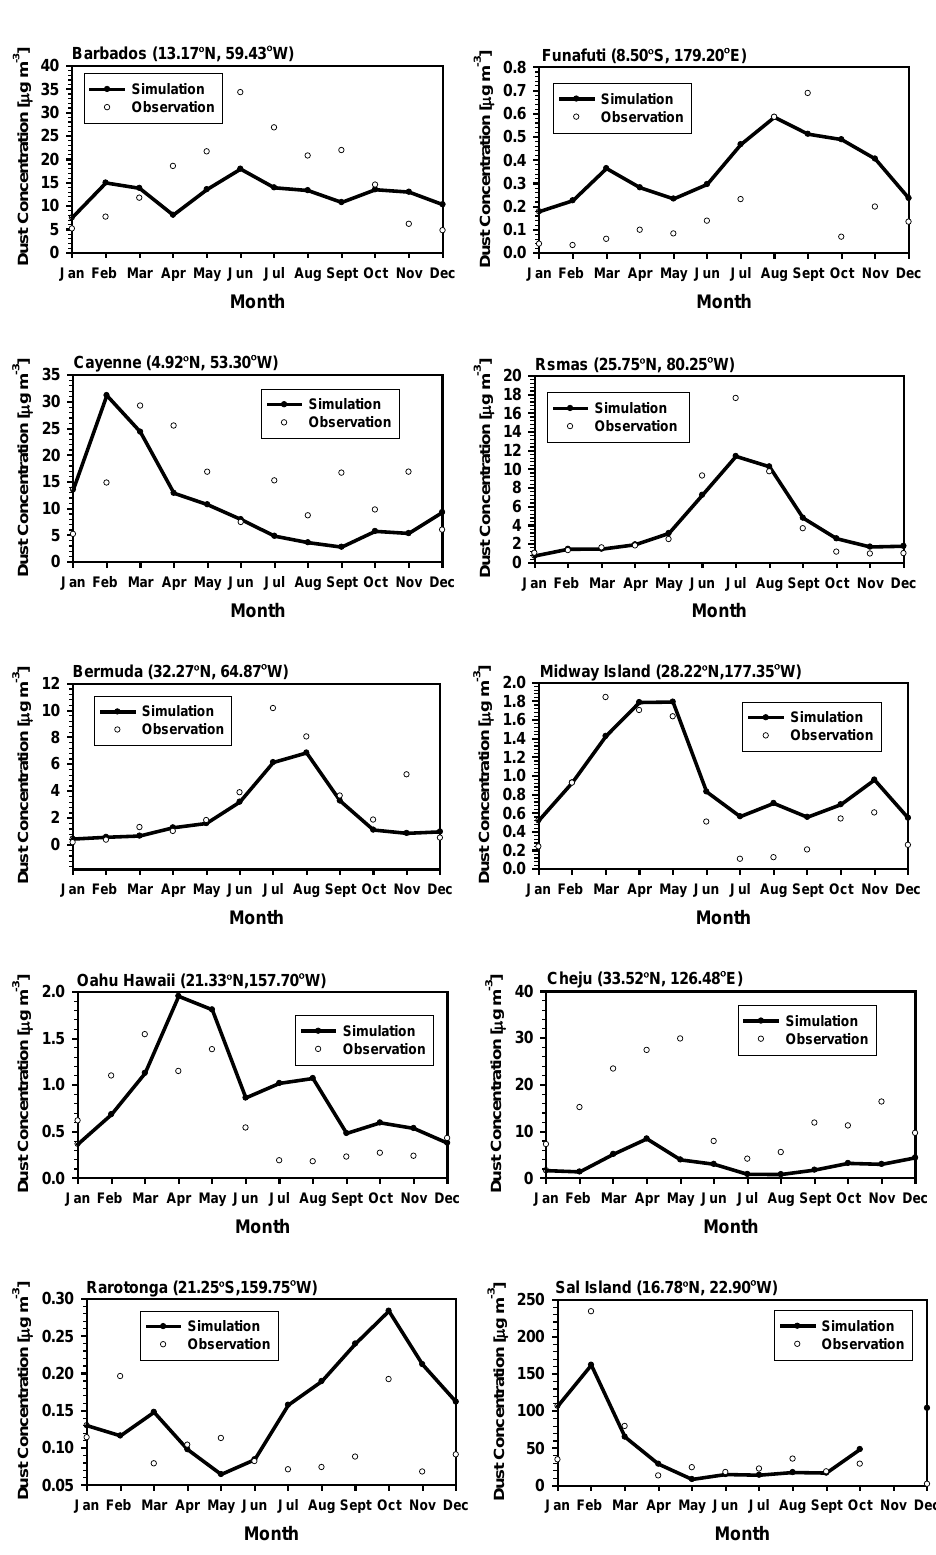
Fig. 13. Comparisons of monthly averaged surface soil dust concentrations for 1995–2004 with observations at Miami University research